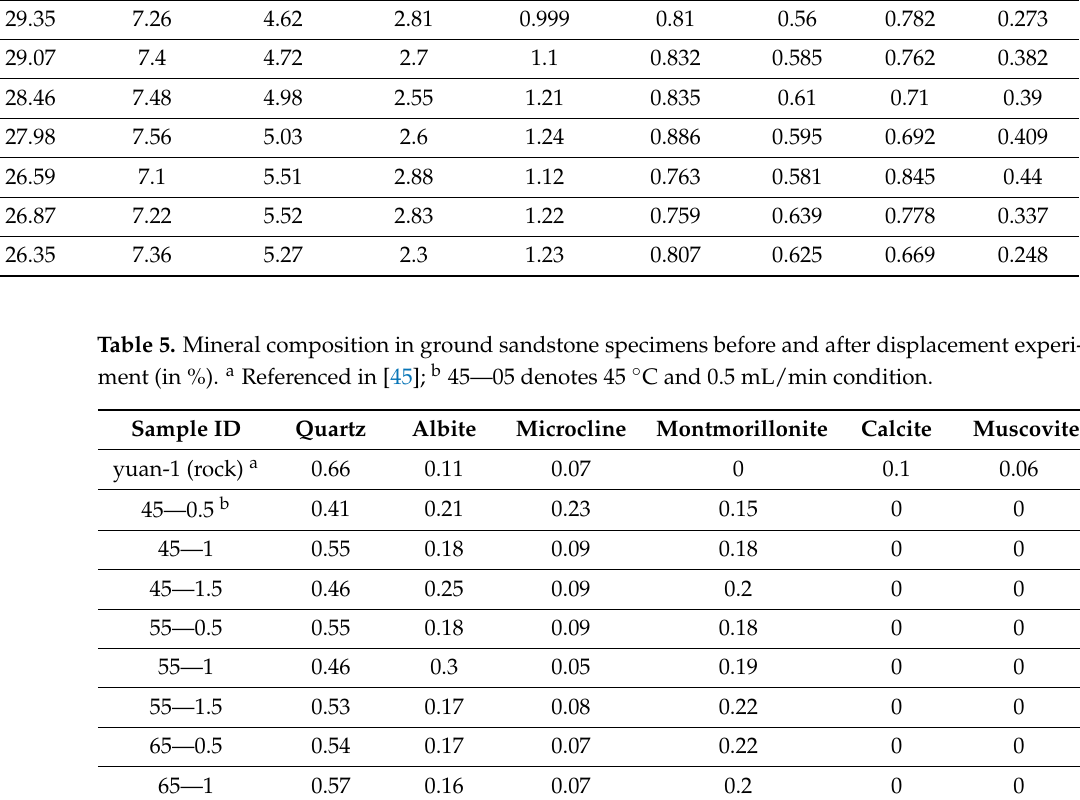
(Figure 3; Table 5). Under the same temperature conditions, both at 45 ◦ C and 55 ◦